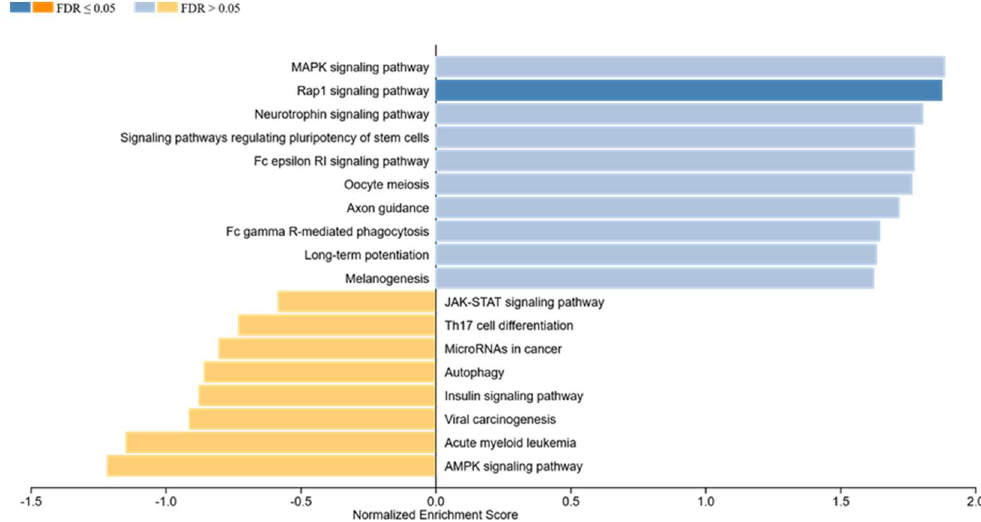
Figure 3. Gene set enrichment analysis in MPM cells being treated with FB CM. Among others, particularly the MAPK-RAP1 and the Fc receptor signalling pathway showed significant associations. These pathways were activated in treated MPM cell lines.